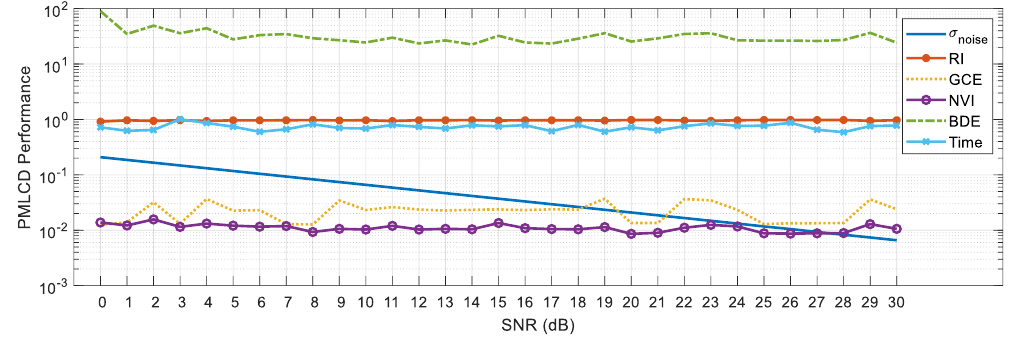
Figure 14. The benchmarks of the PMLCD method applied to the noisy VOC2012 #2007_001289